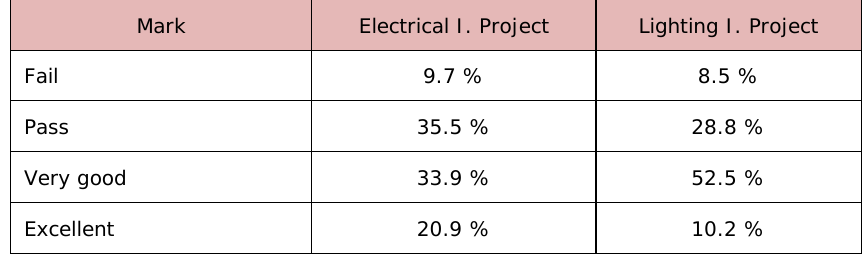
Table 5. “Project marks in percentage”. Source: authors